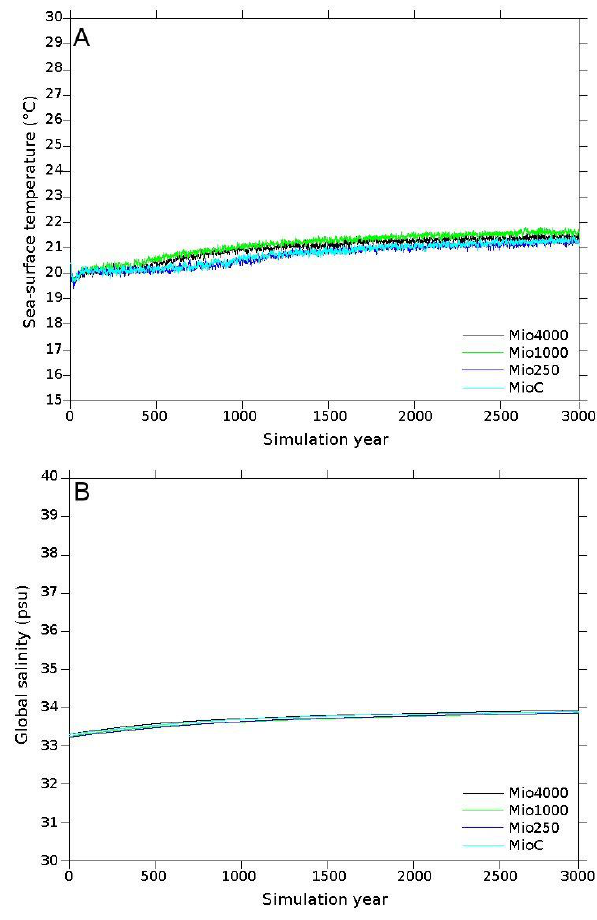
Fig. 2. Evolution of (A) sea-surface temperature ( ◦ C) and (B) global salinity (psu) during the four Miocene